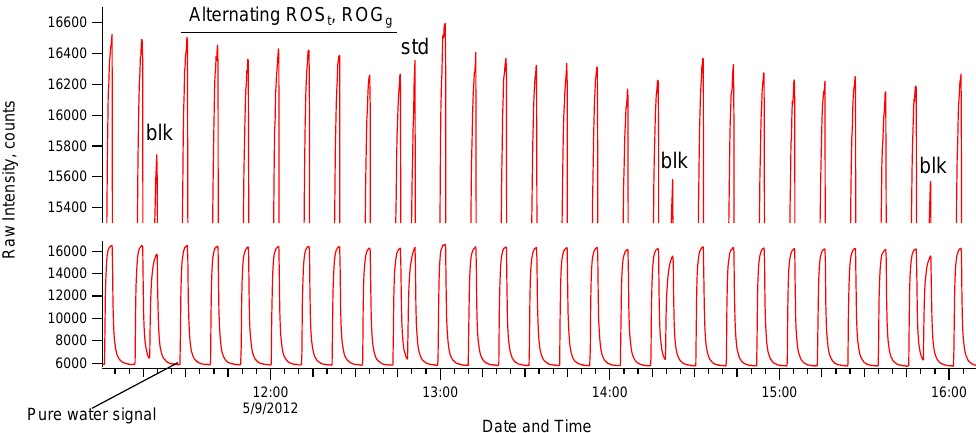
Fig. 8. Time series of raw spectrometer data for ambient ROS measurements showing responses for pure water, deionized water+DCFH/HRP (blk), online measurements of total and gas ROS, and H 2 O 2 standards (std).